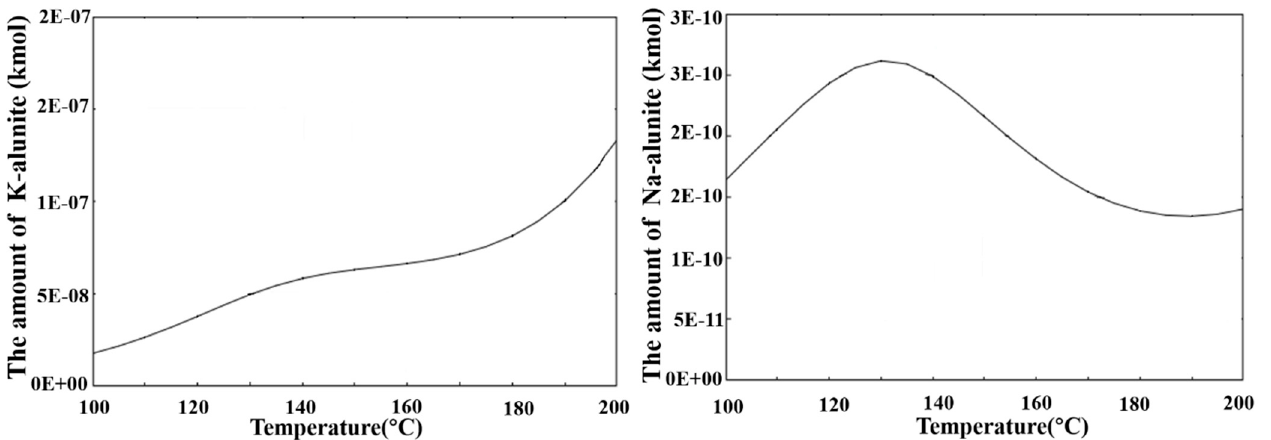
Figure 6. The equilibrium composition diagrams of the K-Na-SO 42 − -H 2 O system.